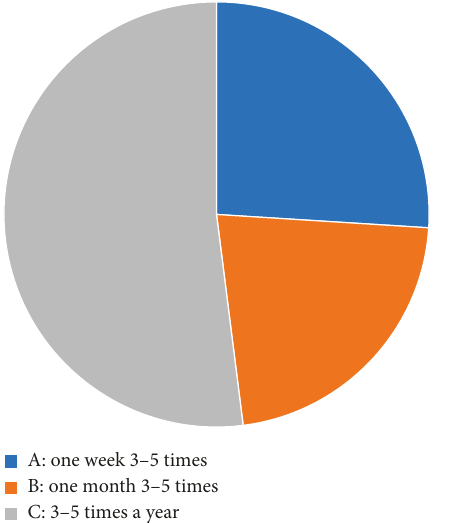
Figure 7: Distribution of respondents by frequency of passing overpasses.